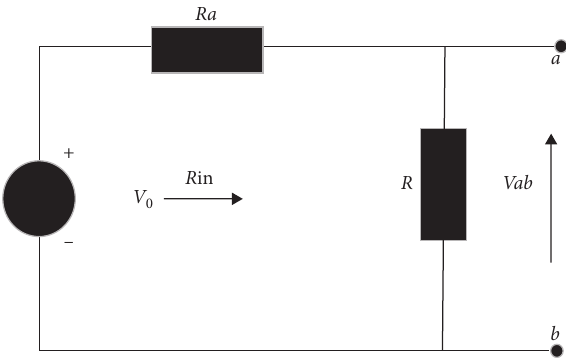
Figure 1: Voltage divider